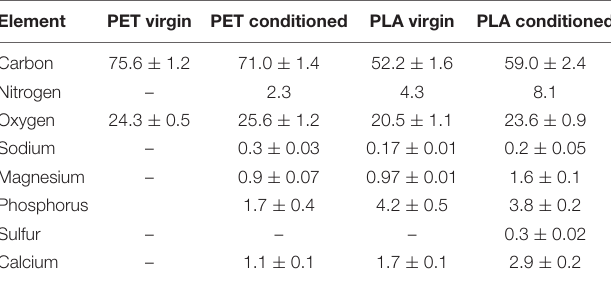
TABLE 2 | Mass percent of elements identified at the surface of virgin and conditioned PET and PLA cards submerged in natural seawater at 22 ◦ C.